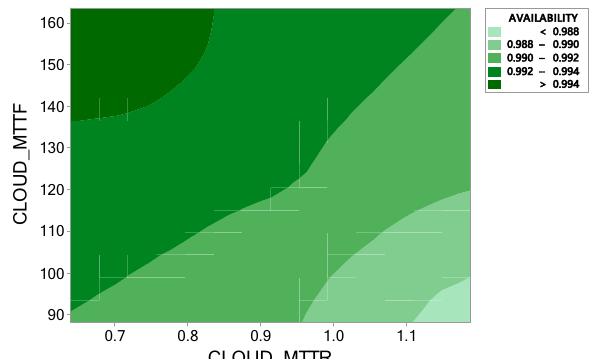
Figure 9. The color zones show the interaction of the cloud with availability. The darker the color, the better the